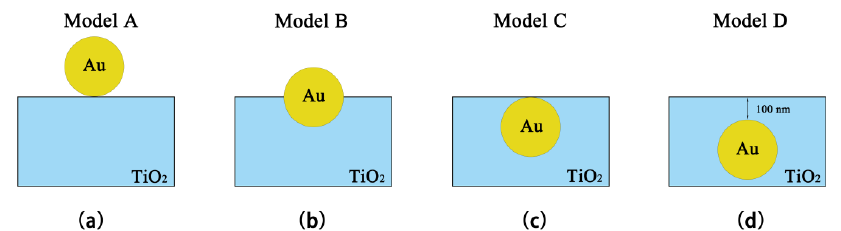
Figure 1. The location of Au nanoparticles loaded on the TiO 2 substrate: ( a ) The Au nanoparticle just